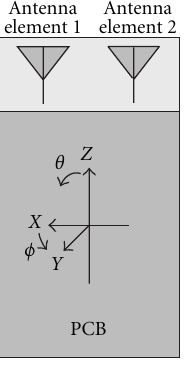
Figure 1: Spherical coordinate